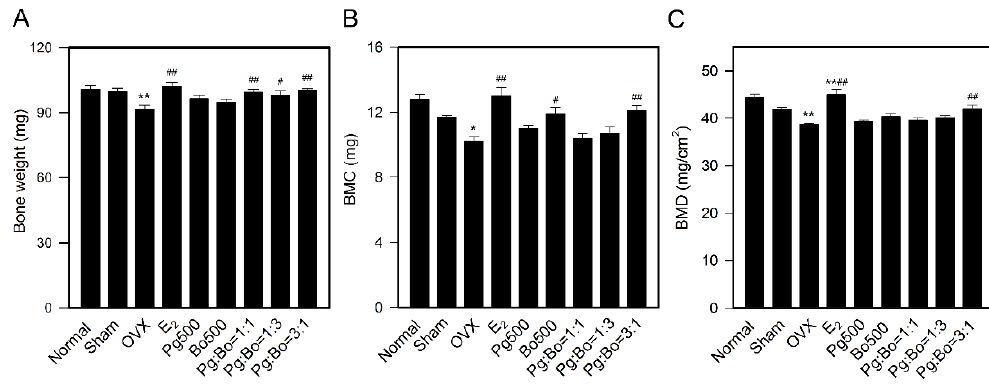
Figure 3. Effect of Pg and Bo on bone weight and bone mineral density. ( A ) Bone weight was measured on the day of sacrifice ( n = 10). Bone mineral content (BMC) ( B ) and bone mineral density (BMD) ( C ) of right femurs were measured using a DXA ( n = 8). All values are expressed as mean ± SEM. * p < 0.05 and ** p < 0.01 compared with Sham, # p < 0.05 and ## p < 0.01 compared with OVX.